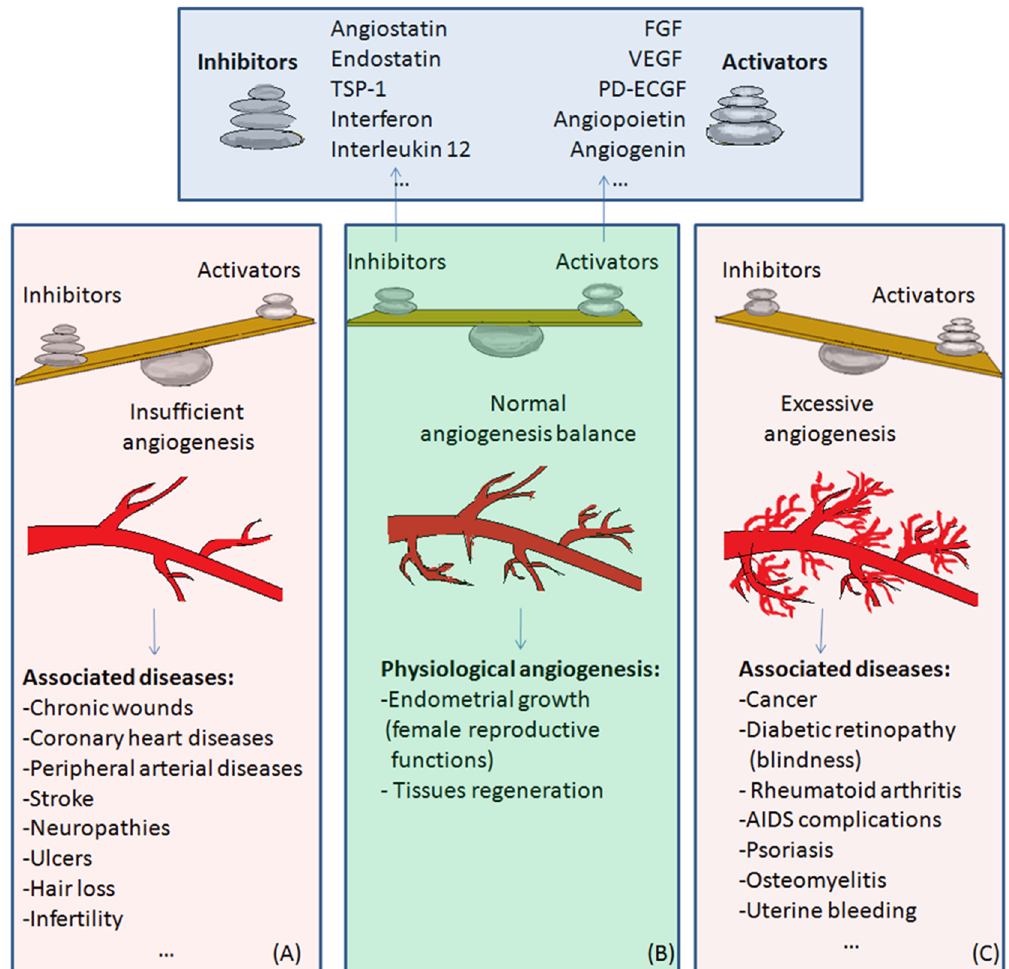
Figure 2. The balance of activators and inhibitors in: ( A )—insufficient angiogenesis; ( B )—normal angiogenesis; ( C )—excessive angiogenesis. Abbreviations: FGF: fibroblast growth factor, VEGF: vascular endothelial growth factor, PD-ECGF: platelet-derived endothelial cell growth factor, TSP-1: thrombospondin-1.